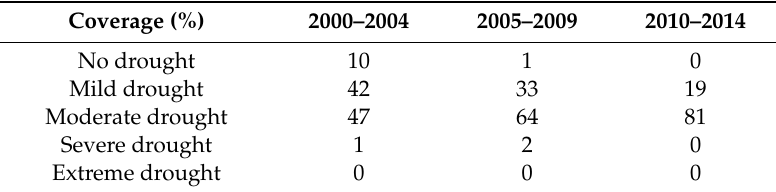
Table 3. Spatial coverage of drought intensity categories in the Kilombero River catchment between the years 2001 and 2014.